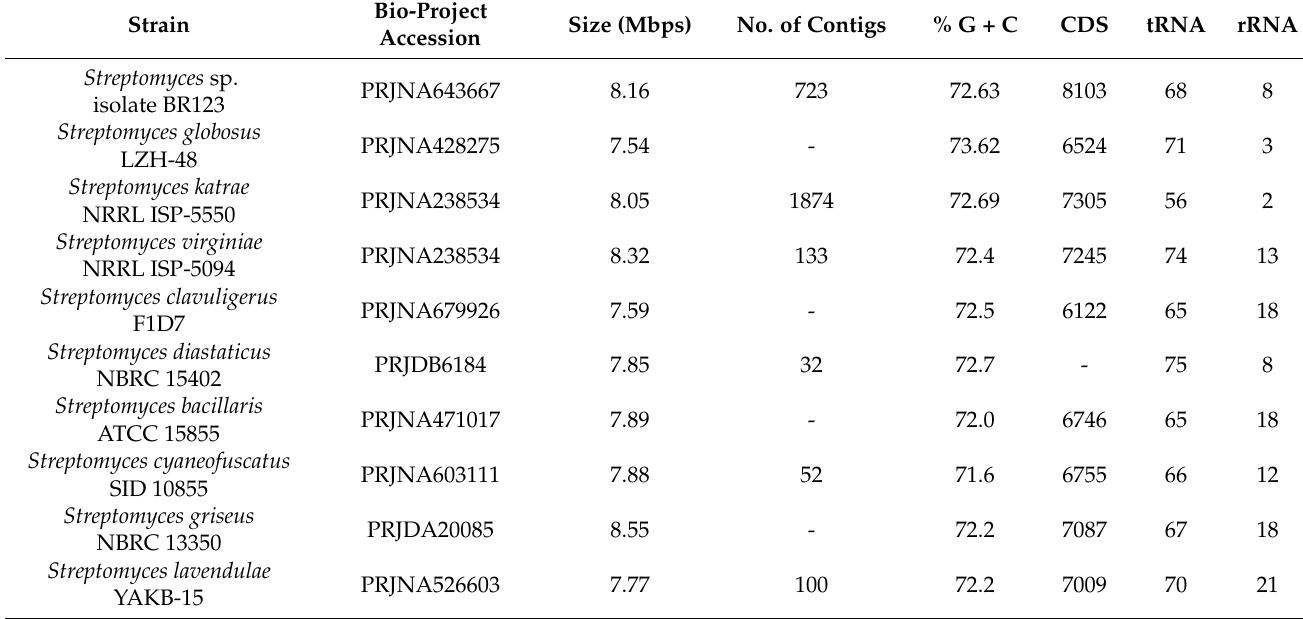
Table 1. General genomic features of Streptomyces sp. isolate BR123 and other species used in this study.